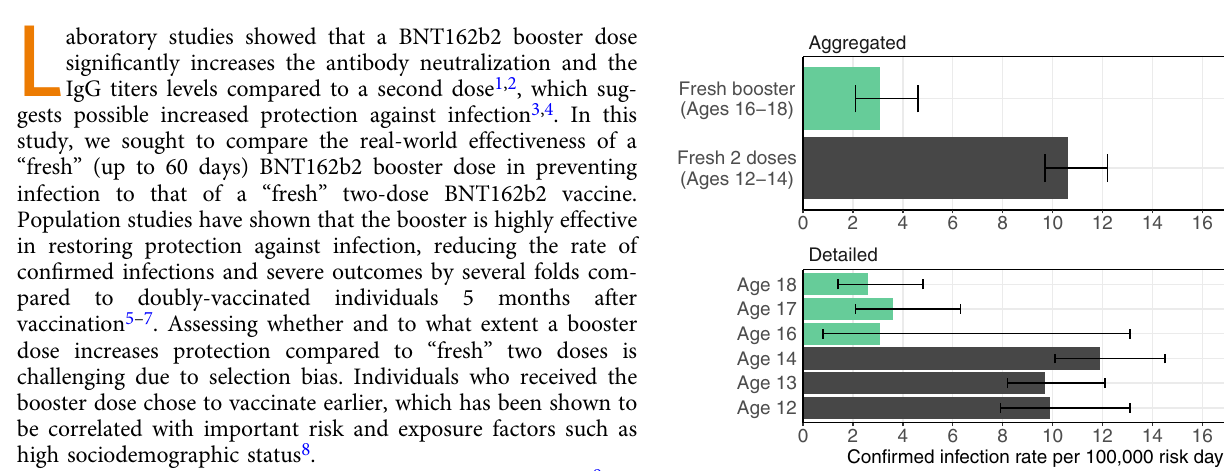
Fig. 1 Estimated covariate-adjusted rates of con fi rmed infections per 100,000 at-risk days. Estimates were obtained from Poisson regression analysis for the study period from September 12, 2021 to October 9, 2021, strati fi ed by cohorts, with n = 4,361,550 days at risk. The top plot shows the results of the main analysis of the two study cohorts. The bottom plot shows covariate-adjusted rates of con fi rmed infections for each age group. Errors bars show 95% con fi dence intervals (not adjusted for